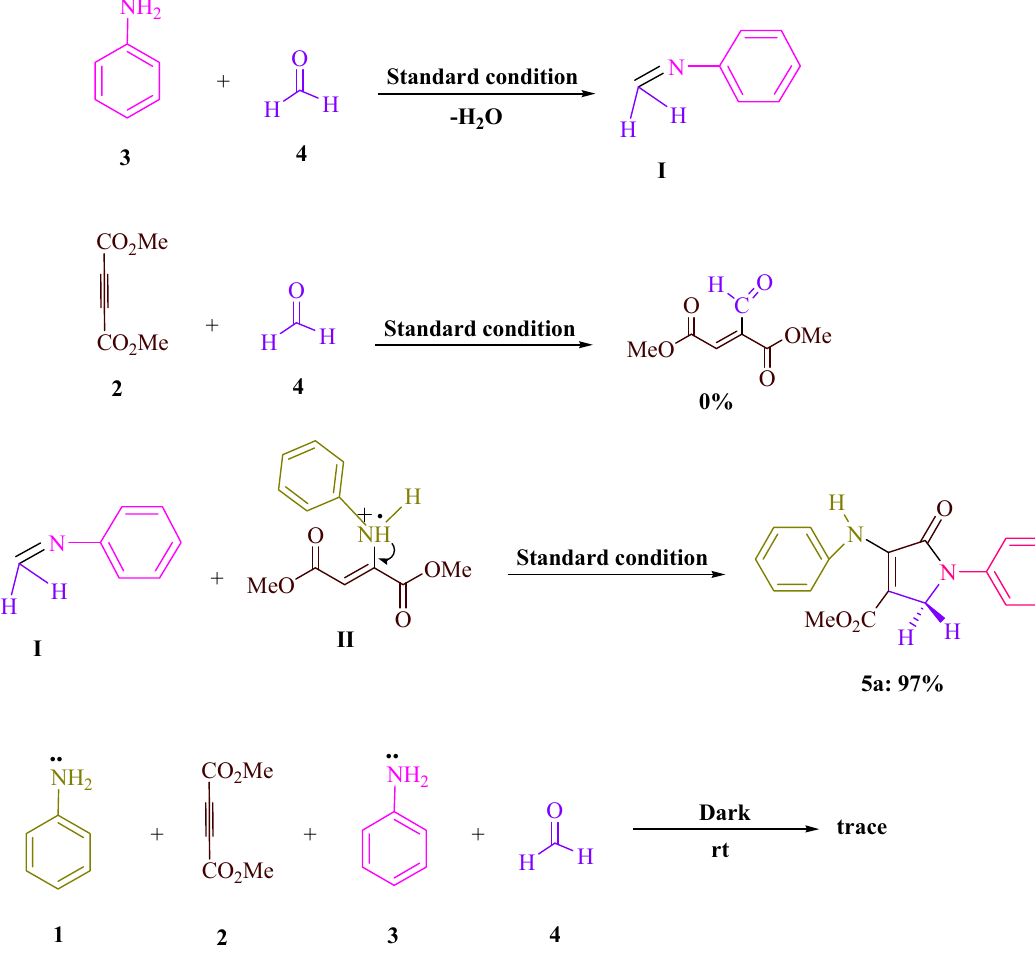
Figure 5. DMAD ( 2 , 1 mmol), aniline ( 1 and 3 , 2 mmol), and formaldehyde ( 4 , 1.5 mmol) reactions provide important control studies for understanding their